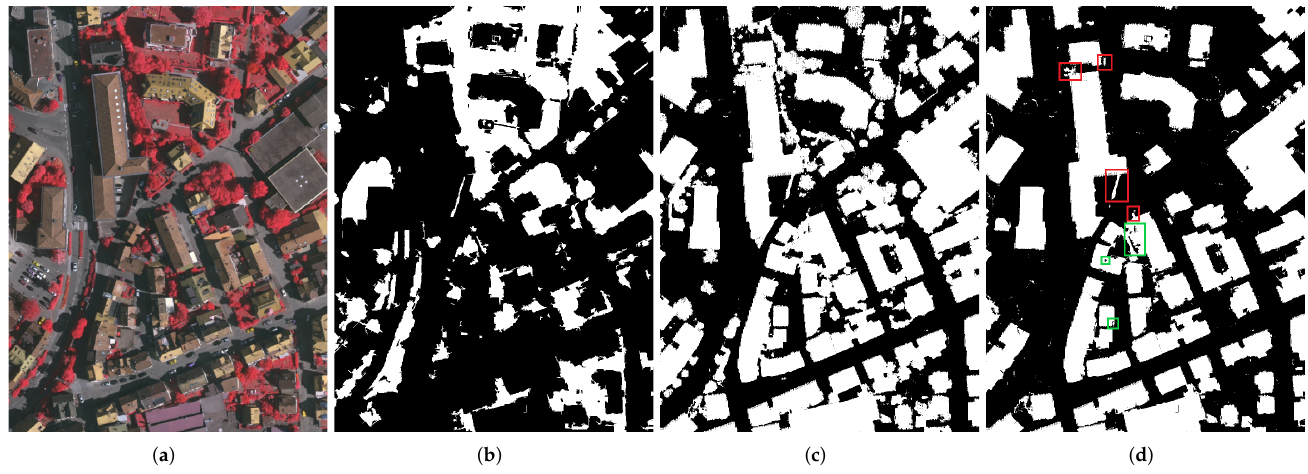
Figure 1. Illustration of the generation of the initial building mask. ( a ) The first image of the Vaihingen dataset; ( b ) vegetation detection result of the proposed iSH+eSH method; ( c ) the nDSM processed by the moment-preserving method [73]; ( d ) initial building mask (the nDSM where the vegetation recognised by the iSH+eSH method has been removed). The detected vegetation regions in ( b ) and building regions in ( d ), and the non-ground points of the nDSM in ( c ) are marked in